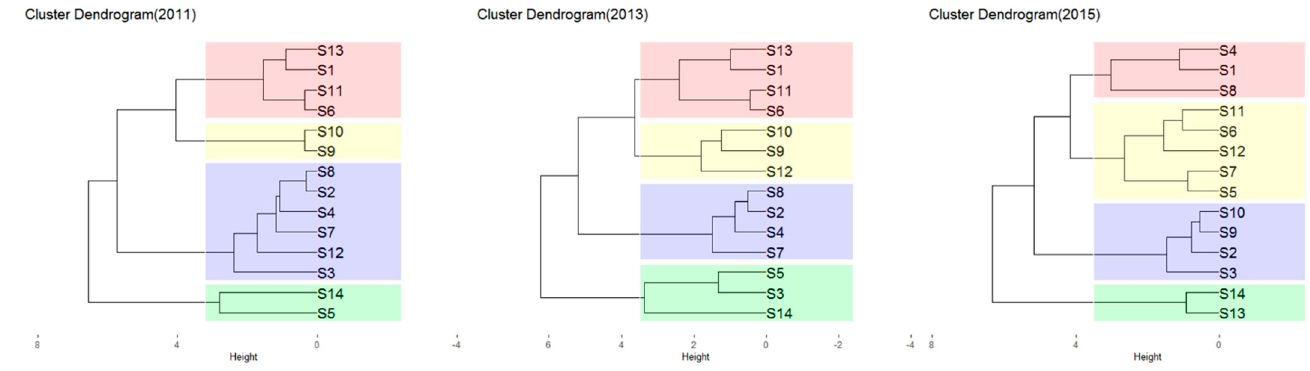
Figure 7. The dendrogram of the 14 communities through hierarchical cluster analysis (2011, 2013,